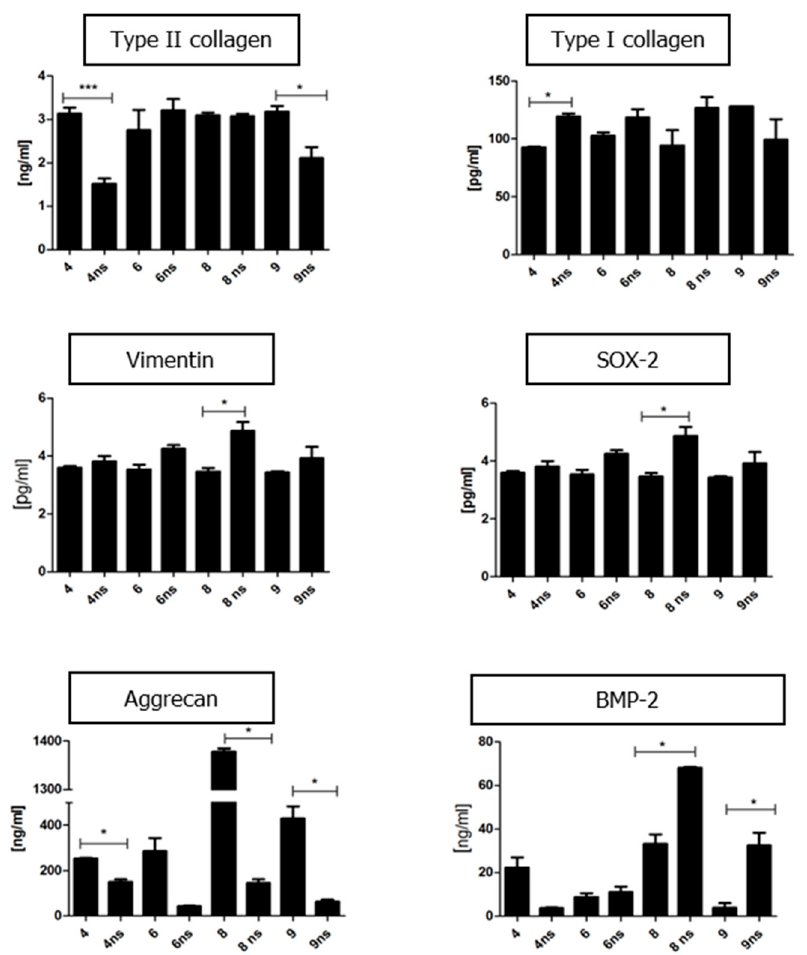
Figure 13. The levels of analysed proteins in chondrogenic and standard (ns) conditions in each tested biomaterial; * p < 0.05, *** p < 0.001 (materials described in Table